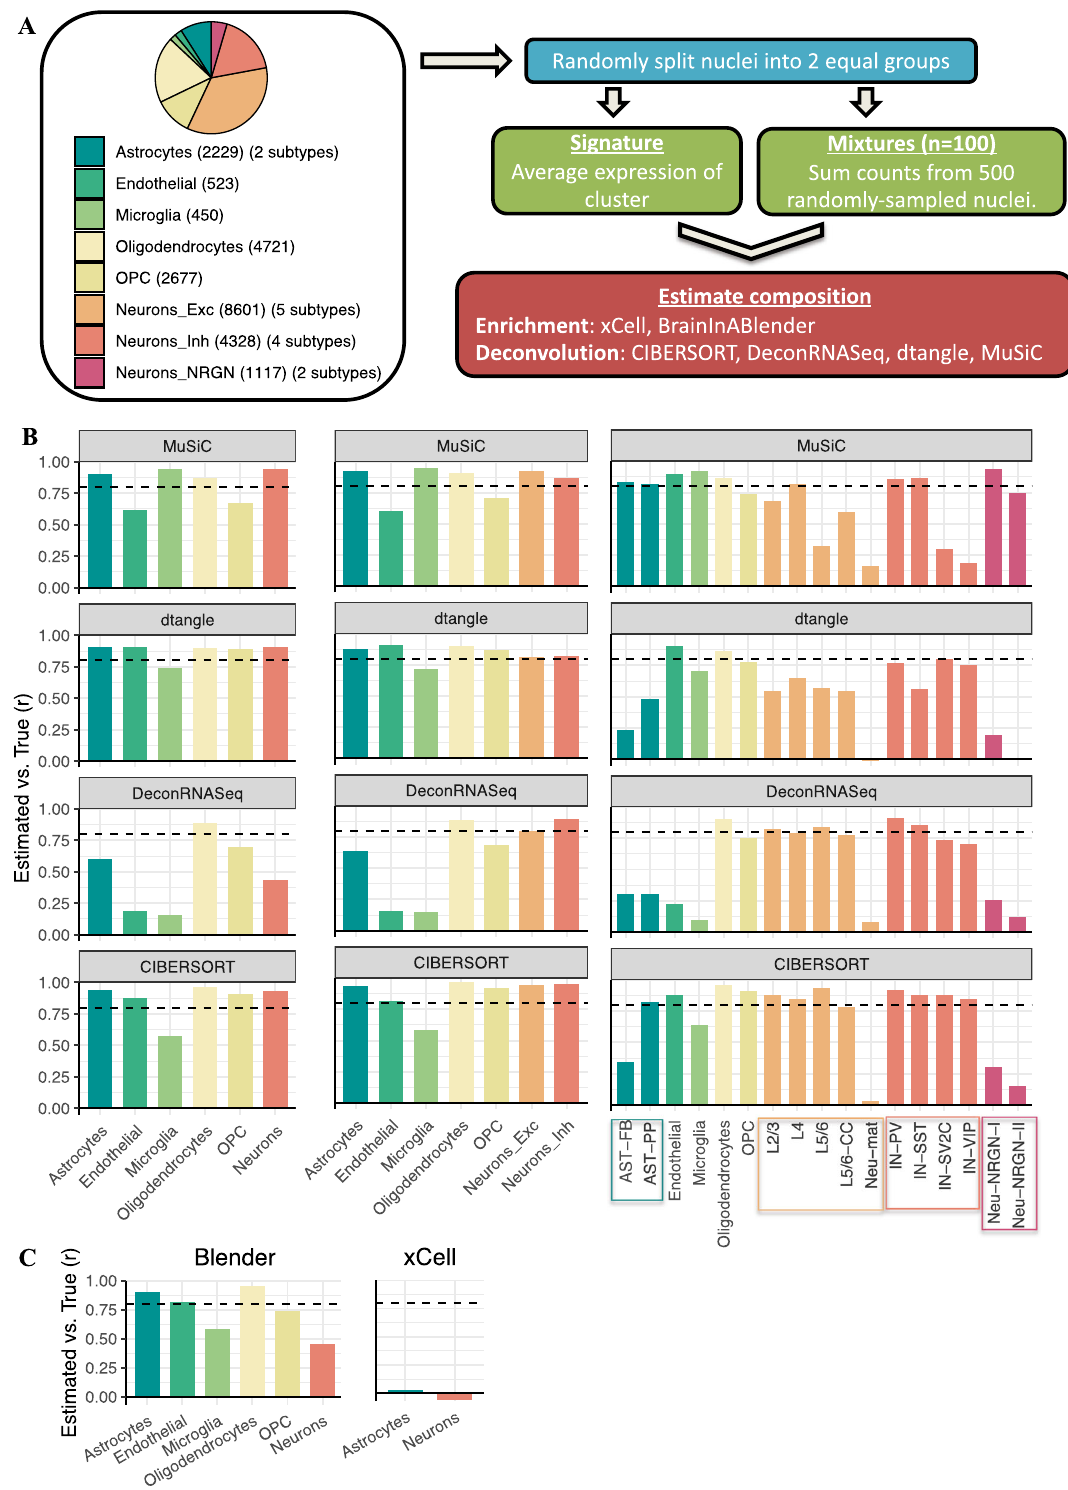
Fig. 1 Deconvolution accuracy across methods. A Simulation design. Single-nucleus RNA sequencing data was acquired from Velmeshev et al. and used to create 100 in silico mixtures with known proportions (see the “ Methods ” section). Left: Piechart displaying the composition of the dataset, where n is the number of cells per cell-type. The number of sub-types is listed in between brackets. Right: analysis outline. OPC oligodendrocyte precursor cells. Neurons_Exc, Neurons_Inh, and Neurons_NRGN: excitatory, inhibitory, and NRGN + neurons, respectively. DRS DeconRNASeq, CIB CIBERSORT, Blender BrainInABlender. B Barplots of Pearson correlation coef fi cients ( r ) between true and estimated cell-type proportions in 100 in silico mixtures. Left: cells are grouped by major cell-types; middle: excitatory and inhibitory neuron subtypes are included in the signature; right: all cell-subtype labels are used in the signature. C Barplots of Pearson correlation coef fi cients ( r ) between true proportion and cell-type enrichment scores. Dotted horizontal lines: r =